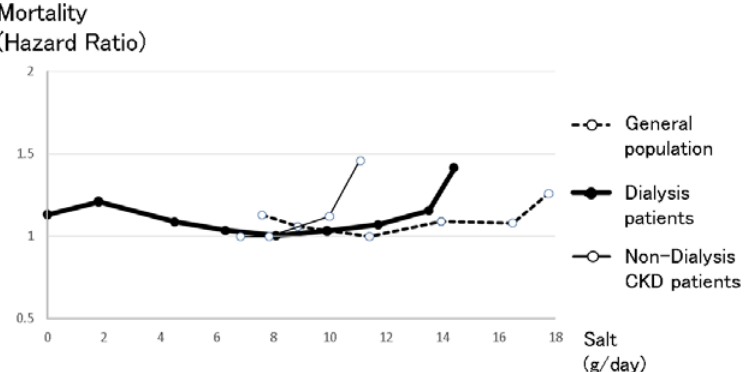
Figure 5. The relationship between salt intake and mortality in the general population, non-dialysis CKD patients and dialysis patients. The right line shows the relationship between salt intake and mortality in the general population, which was made from data reported by O’Donnell et al. [16]. Intake of more than 17.8 g salt/day made the prognosis significantly worse after diet adjustments, while intake of less than 7.6 g salt/day also made the prognosis worse. The center bold line shows the relationship between salt intake and mortality in dialysis patients, which was made from the relationship between intradialysis body weight gain and mortality reported by the Japan Society of Dialysis Therapy. Intake of more than 12.6 g salt/day made the prognosis significantly worse after diet adjustments, while intake of less than 5.4 g salt/day also made the prognosis worse. The left line shows the relationship between salt intake and mortality in non-dialysis CKD patients, which was made from data reported by the CRIC cohort study [30]. Non-dialysis CKD patients were more vulnerable to salt intake than the other groups, likely because excess sodium intake increases blood pressure and proteinuria, resulting in worsening prognosis. Simple comparisons should be considered because these three lines refer to different cohorts that originate in different countries, with different observation periods and numbers.